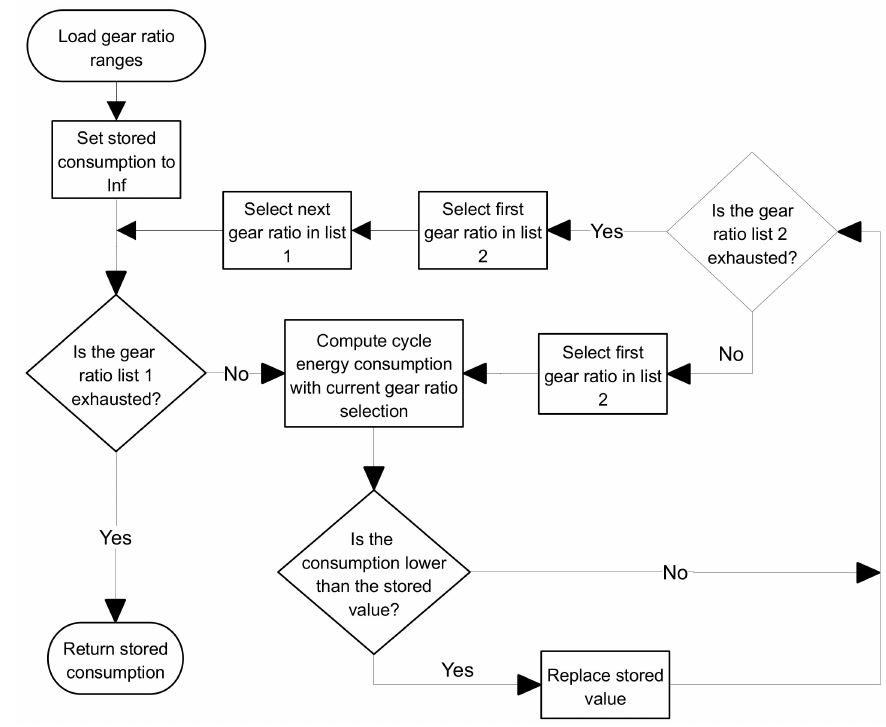
Figure 3. Flow chart of the gear ratio optimization